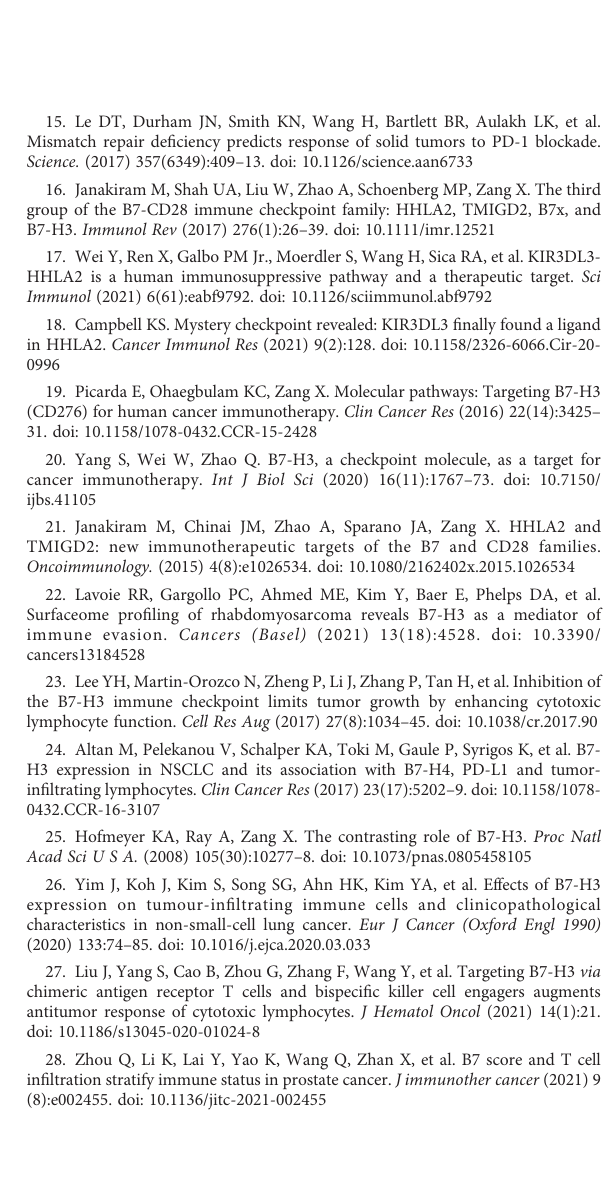
SUPPLEMENTARY FIGURE 5 Instructions for the dynamic nomogram of the Immune-TNM prediction model on the webpage, Linkage to https://dynnomo-for-gallbladder-